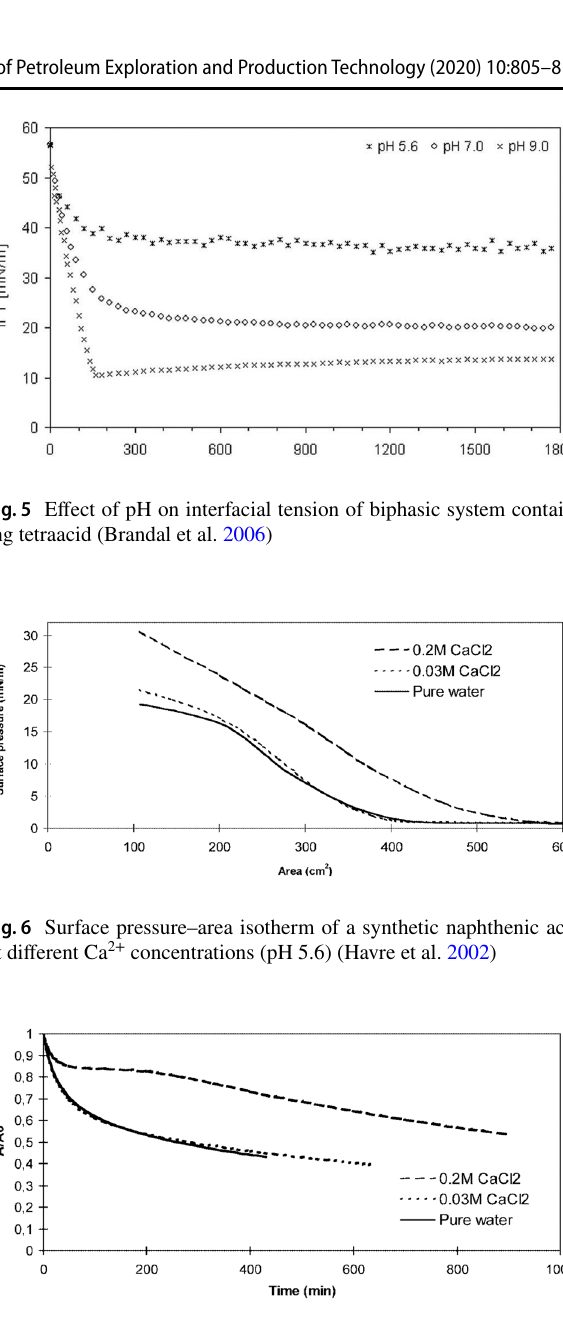
Fig. 7 Interfacial film stability of synthetic naphthenic acid at differ- ent Ca 2+ concentrations (pH 5.6) (Havre et al.